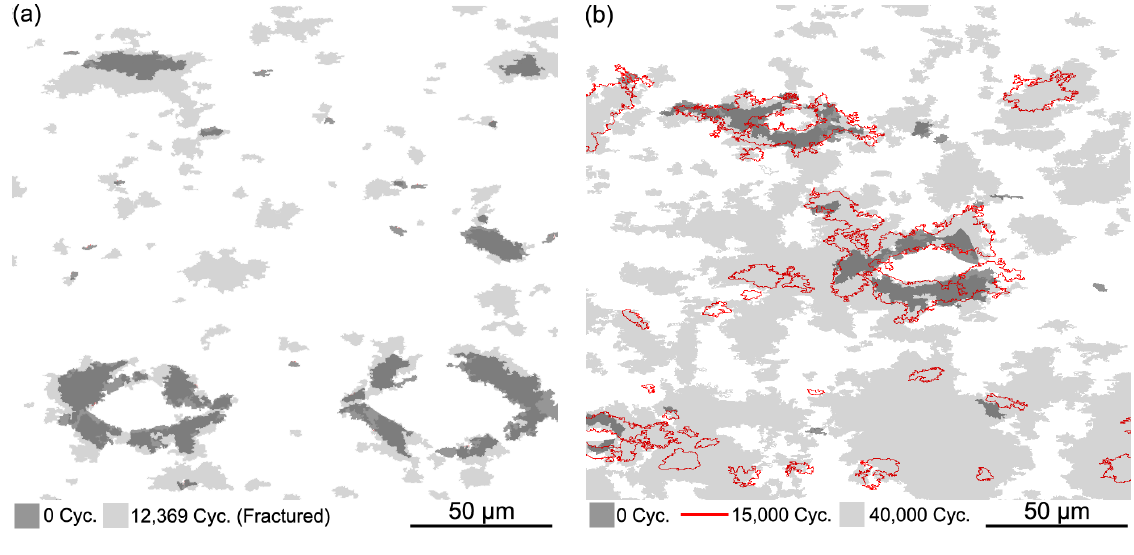
Figure 4. Overlays of the development of the coarse grain constituent of two 7 passes ARBed copper samples with similar initial microstructure upon cyclic straining at Δε /2 = 1.7 × 10 − 3 . ( a ) Sample cyclically tested to fracture without any intervention; total ( b ) Sample with surface damages removed by ion milling at various points along the cyclic lifespan such that the cyclic lifespan can be elongated